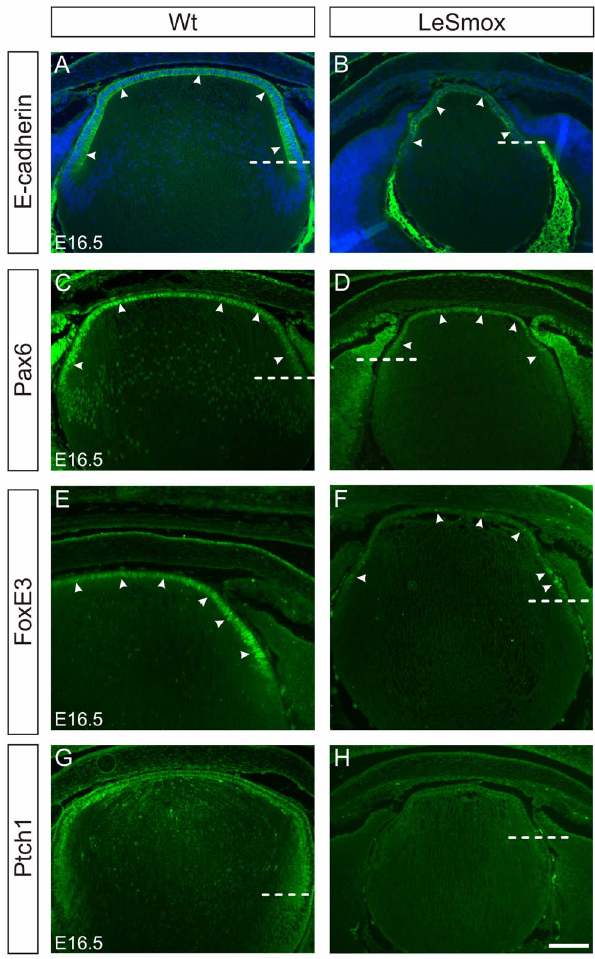
Figure 6. Expression of epithelial cell markers in LeSmox lenses. Expression of E-cadherin ( A, B ), Pax6 ( C–D ), FoxE3 ( E–F ) and Ptch1 ( G, H ) proteins in Wt ( A, C, E, G ) and LeSmox ( B, D, F, H ) lenses at E16.5. A–D. Reactivity for both E-cadherin and Pax6 proteins is detected in epithelial cells (arrowheads) anterior to the lens equator (dashed line) in Wt and in LeSmox lenses. While the extent of the epithelium in LeSmox mice is decreased, the patterns of protein expression are similar to Wt. E–F. FoxE3 is normally detected as a nuclear reactivity in wild-type lens epithelium (arrowheads) but in LeSmox lenses the reactivity is reduced and is absent from many nuclei. The strongest FoxE3 reactivity is detected in equatorial nuclei. G–H. Ptch1 is predominantly detected in Wt epithelial cells and declines as cells commenced differentiation at the equator ( G ). In LeSmox lenses, reactivity for Ptch1 is greatly reduced and virtually absent, indicating reduced Hh signalling ( H ). Dashed line indicates position of the lens equator in each image. Scale bar, A–H 100 m